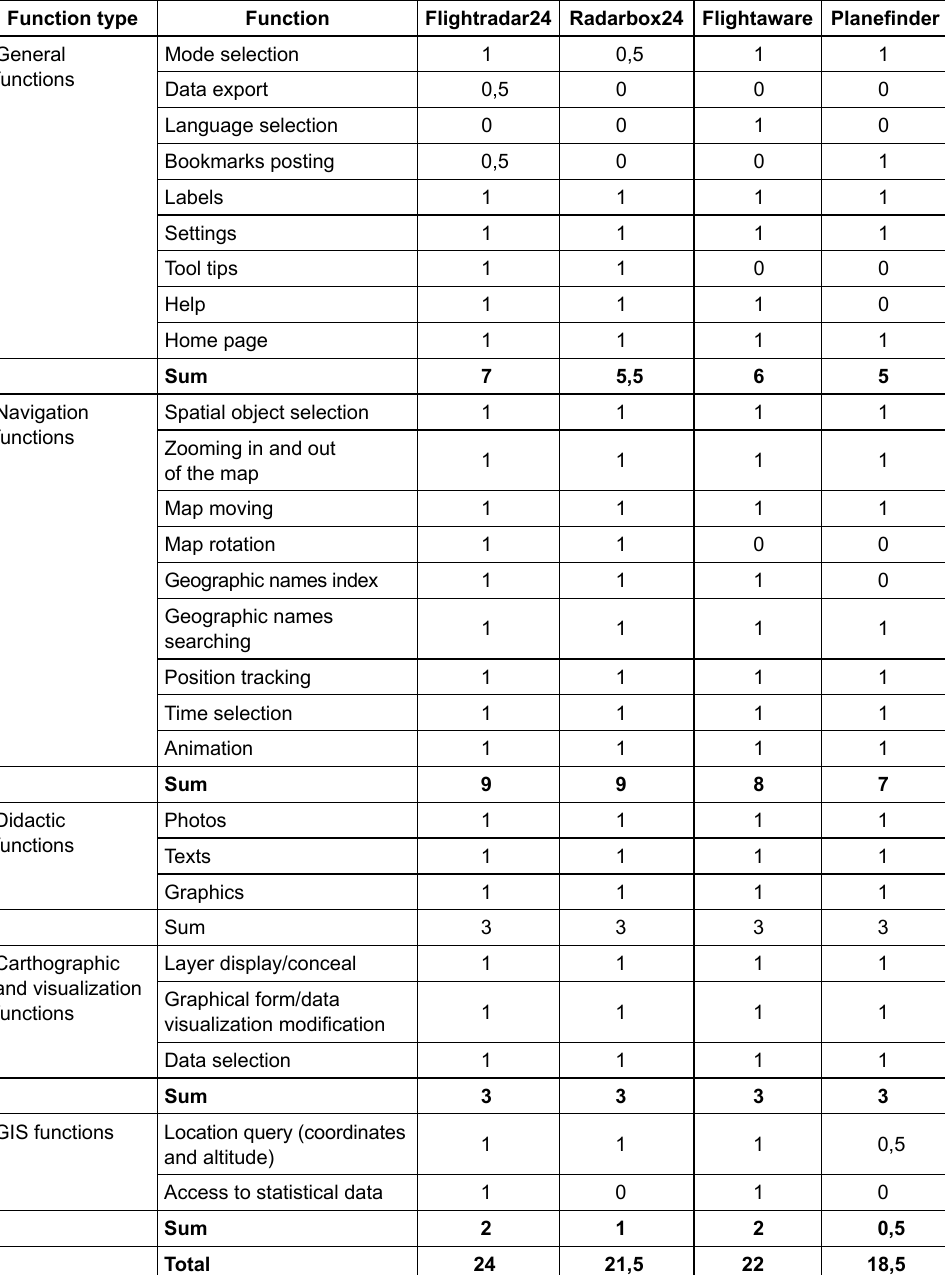
Table 1. Comparison of the functionality of studied websites Function